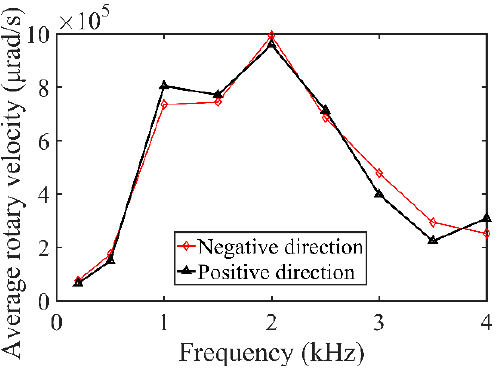
Figure 8. The rotary velocities of the prototype motor under different driving frequencies.